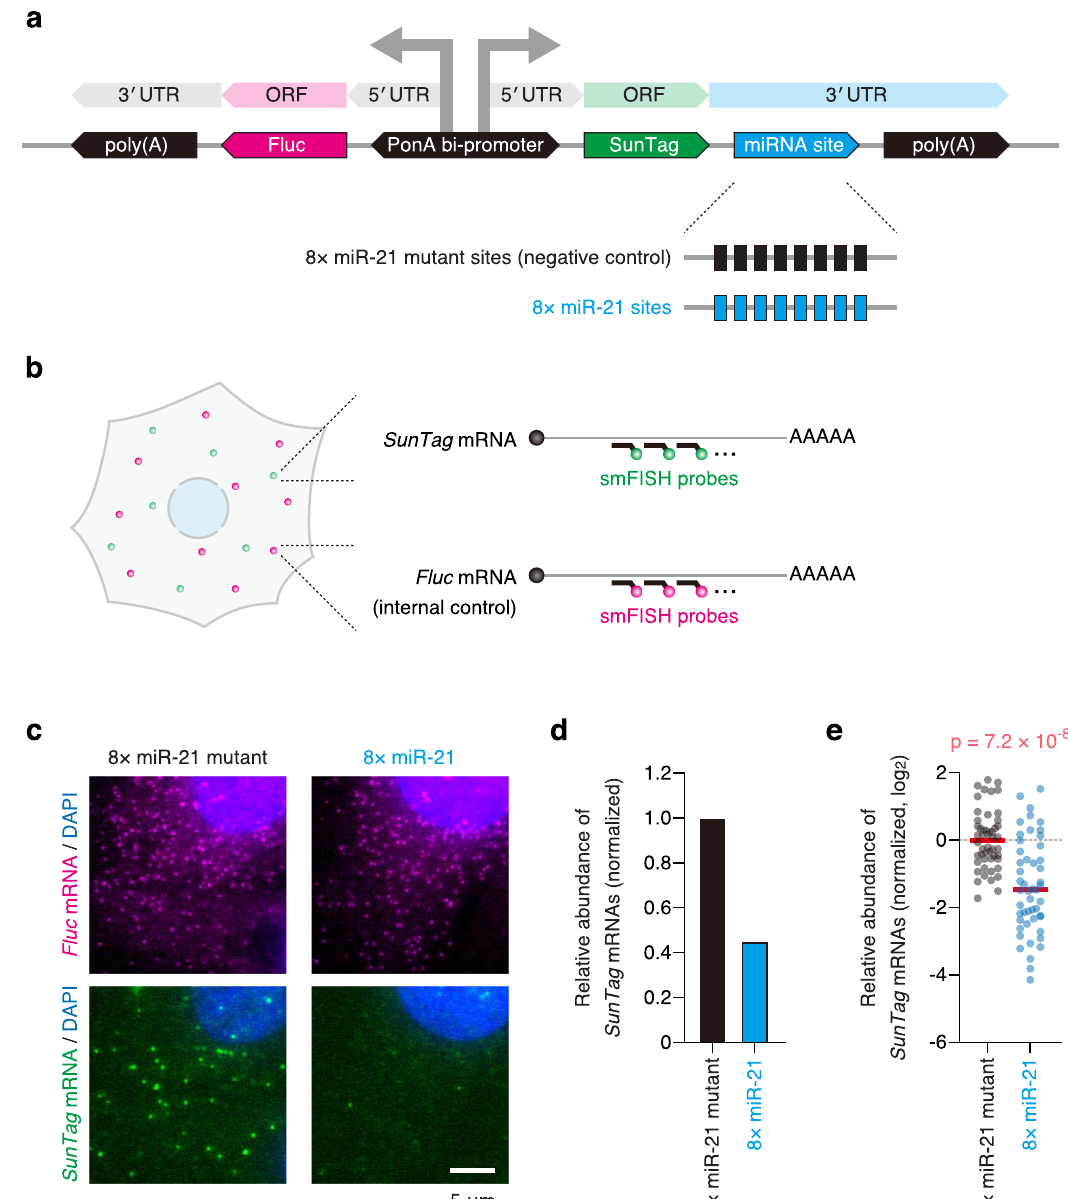
Fig. 1 Single-molecule imaging of miRNA-mediated mRNA decay. a Schematic of the reporter construct to recapitulate miRNA-mediated mRNA decay. PonA bi-promoter, PonA-inducible bi-directional promoter. b Schematic of the smFISH experiment to visualize miRNA-mediated mRNA decay at single- mRNA resolution. Green and magenta spots represent SunTag and Fluc mRNAs, respectively. c The images of U2OS cells expressing the 8× miR-21 mutant reporter (left) and the 8× miR-21 reporter (right). Fluc mRNAs (magenta, top) and SunTag mRNAs (green, bottom) were labeled by smFISH. Nuclei (blue) were stained by DAPI. Scale bar, 5 μ m. d , e mRNA decay mediated by miR-21. Images were analyzed using CellPro fi ler and FISH-quant. Then, mRNA stability (the relative abundance of SunTag mRNAs to Fluc mRNAs) was calculated as described in Supplementary Fig. 2 (see also Methods), followed by normalization to the value of the negative control. The results of bulk analysis ( d ) and single-cell analysis ( e ) are shown. In e , each circle represents a single cell ( n = 50 for each condition), while red lines represent the medians. The p -value of one-tailed Mann – Whitney test is shown. Source data are provided as a Source Data fi using the fl uorescence intensity of free SunTag and that of SunTag on mRNAs (Fig. 2h), the number of ribosomes on translated mRNAs could be roughly estimated 22 (Supplementary Fig. 4). This analysis revealed that miRNAs also reduced the number of ribosomes on translated mRNAs (Supplementary Fig. 6e).